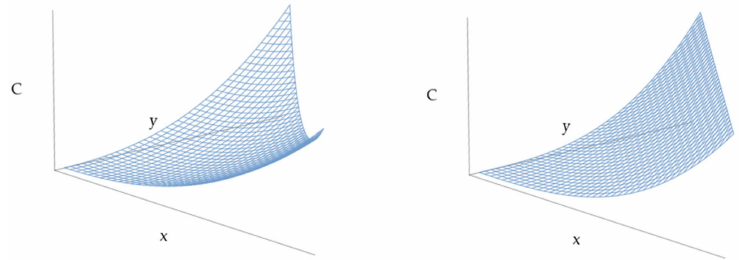
Figure A8. Test shapes of the total cost C